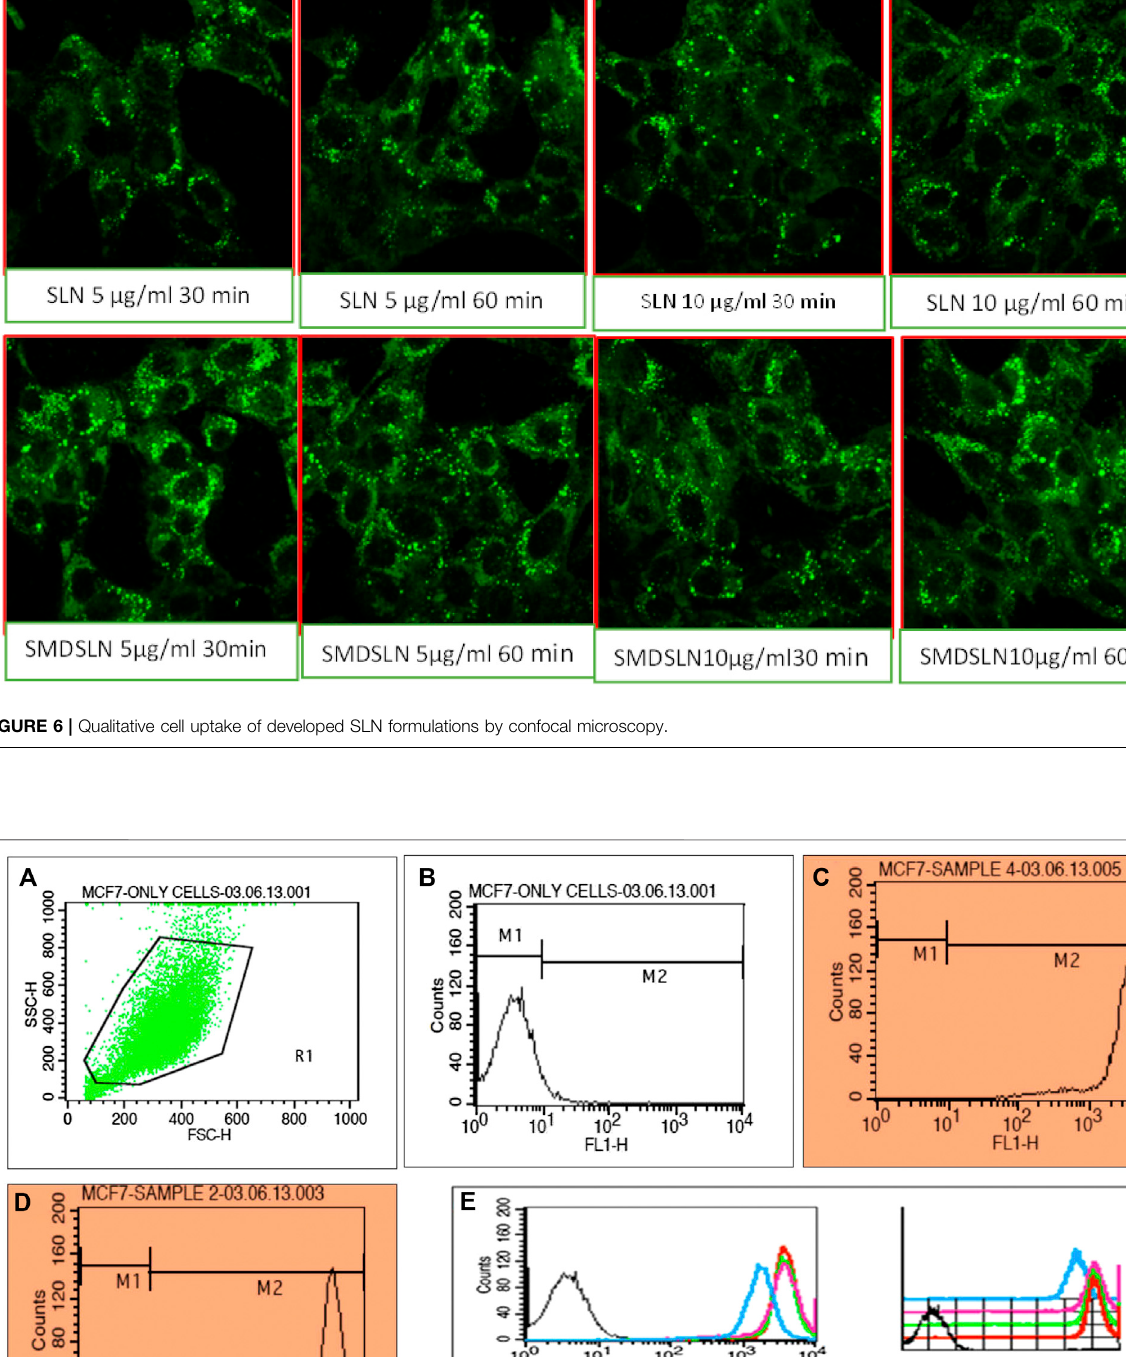
Frontiers in Pharmacology |